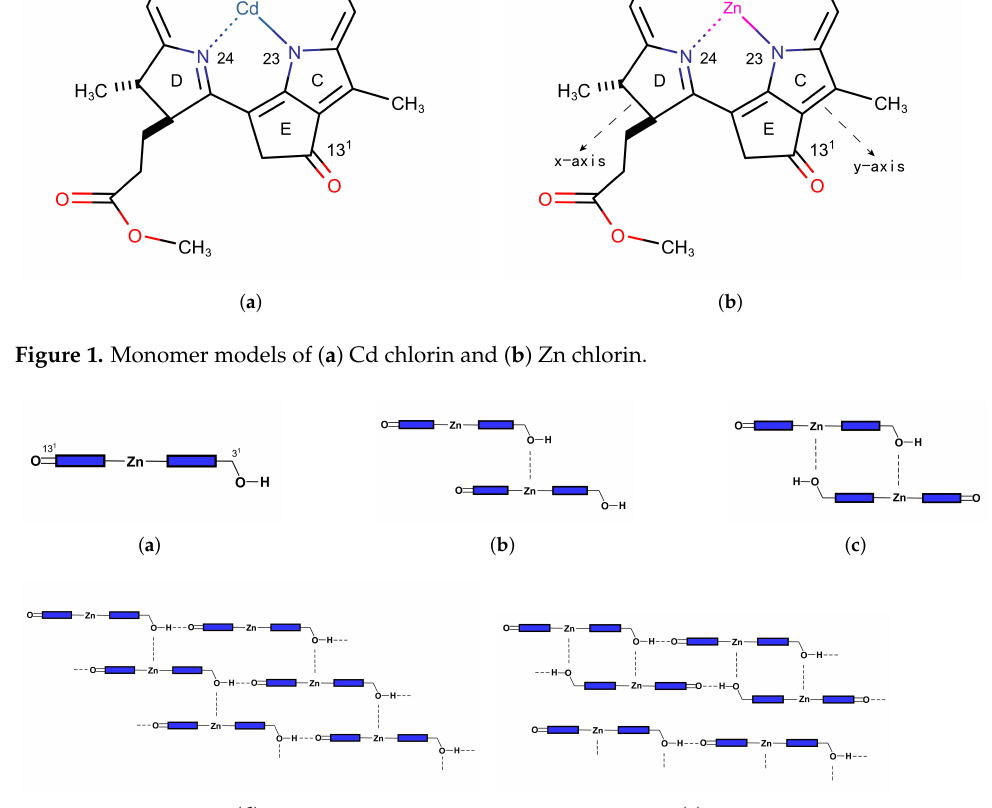
Figure 2. Configurations of ( a ) monomer, ( b ) open dimer, ( c ) closed dimer, ( d ) open aggregate, and ( e ) close